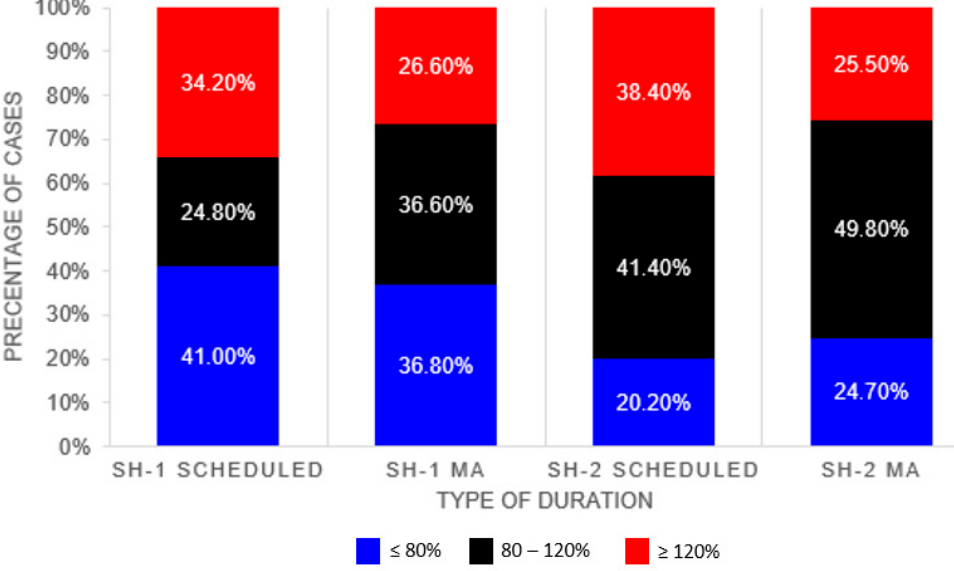
Figure 2. Proportion of Cases within 20% of Actual Durations.